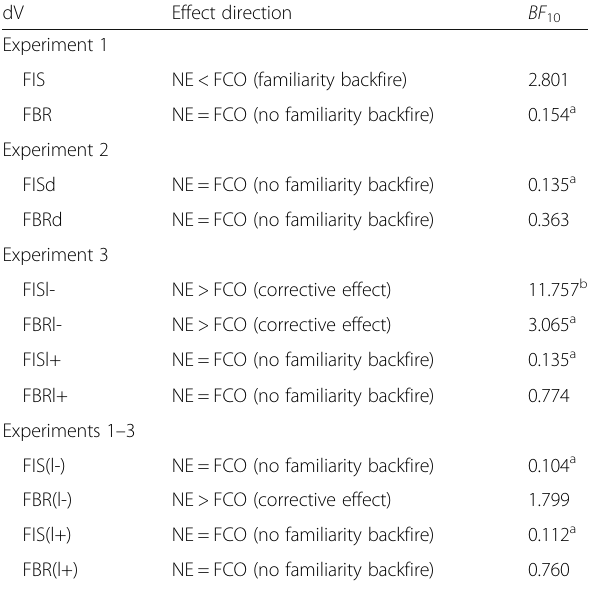
Table 4 Results from Bayesian analyses across Experiments 1 –